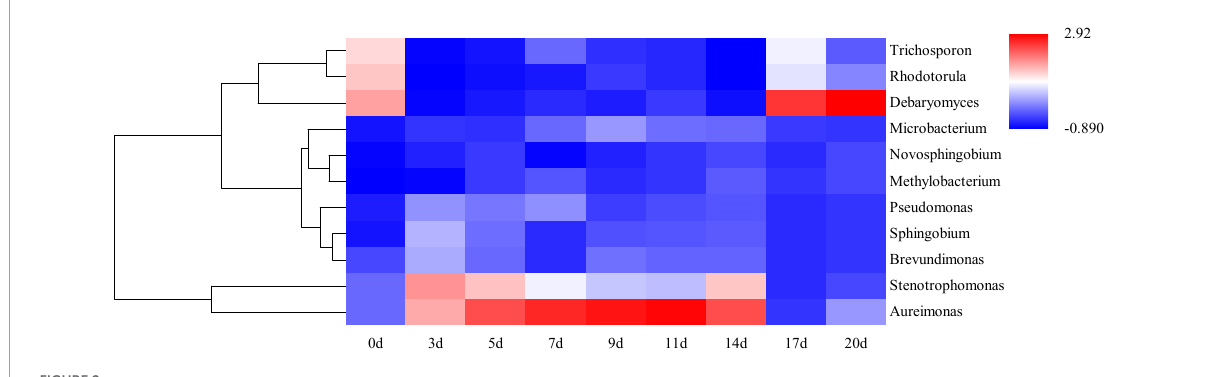
FIGURE2 Hierarchical clustering analysis (HCA) of microbial abundance during the production of fermented minced peppers. The colors corresponded to normalized mean levels from low (blue) to high (red).